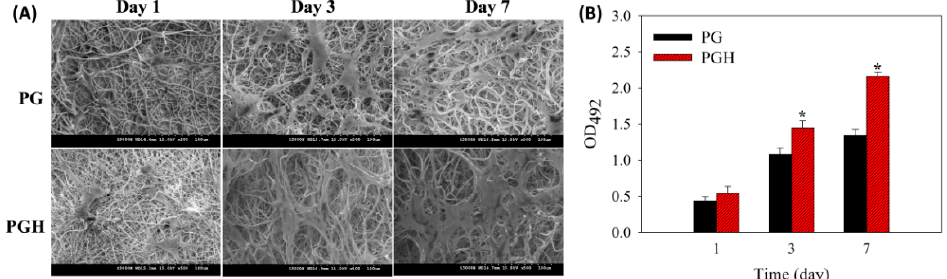
Figure 4. Scanning electron microscope (SEM) images ( A , bar = 100 μ m) and cell proliferation rate ( B ) after culture ASCs in PG or PGH scaffolds. The viable cell number was determined by the MTS assay by measuring the solution absorbance at 492 nm (OD 492 ) in ( B ). * p < 0.05 compared with PG.